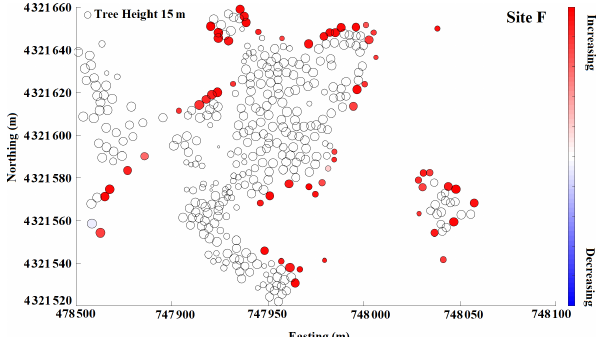
Figure B5. Snow depth change within a 10m buffer from the edge of a tree at site F. Red color indicates snow depth increases moving from the tree edge toward the open areas, and blue indicates snow depth decreases. Increasing and decreasing patterns are shown for individual trees at each site with adequate snow